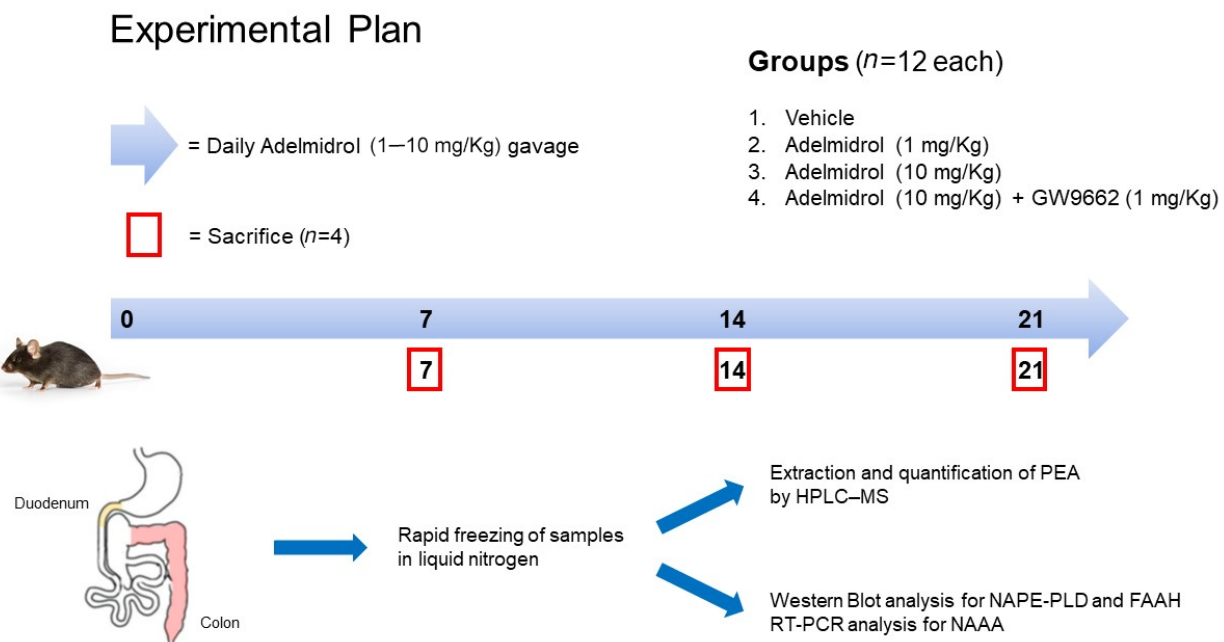
Figure 6. Experimental plan. 4.2. Extraction and Quantification of In Vivo and In Vitro Produced PEA by HPLC–MS Method Extraction and analysis of PEA levels were performed according to Gachet et al. [42], with slight modifications. Mice colonic and duodenal tissues and Caco-2 pellets